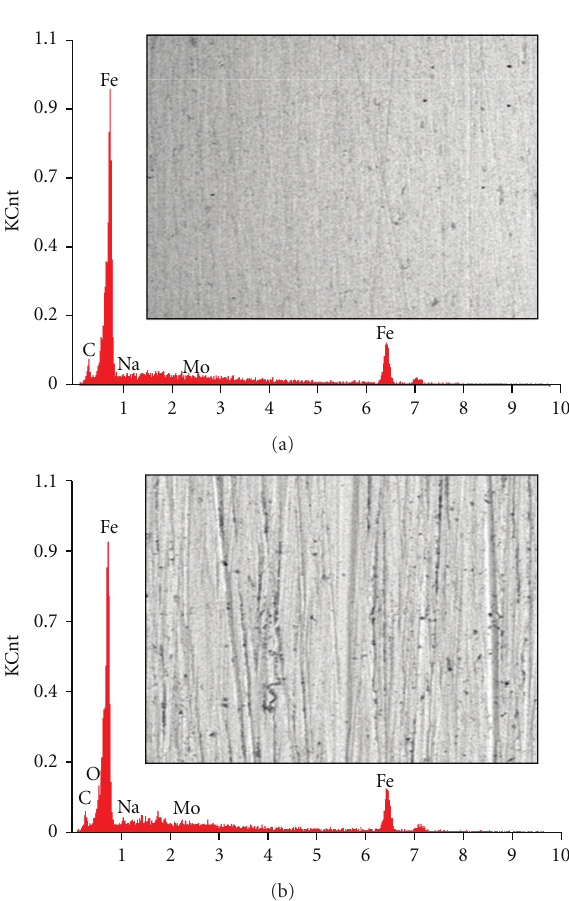
Figure 11: SEM and EDS of carbon steel under galvanic conditions in inhibited RO water by 180 :120 Na 2 MoO 4 and NaNO 2 . Figure 12: SEM and EDS of carbon steel under galvanic conditions in inhibited RO water by 250 :166 Na 2 MoO 4 and NaNO 2 .